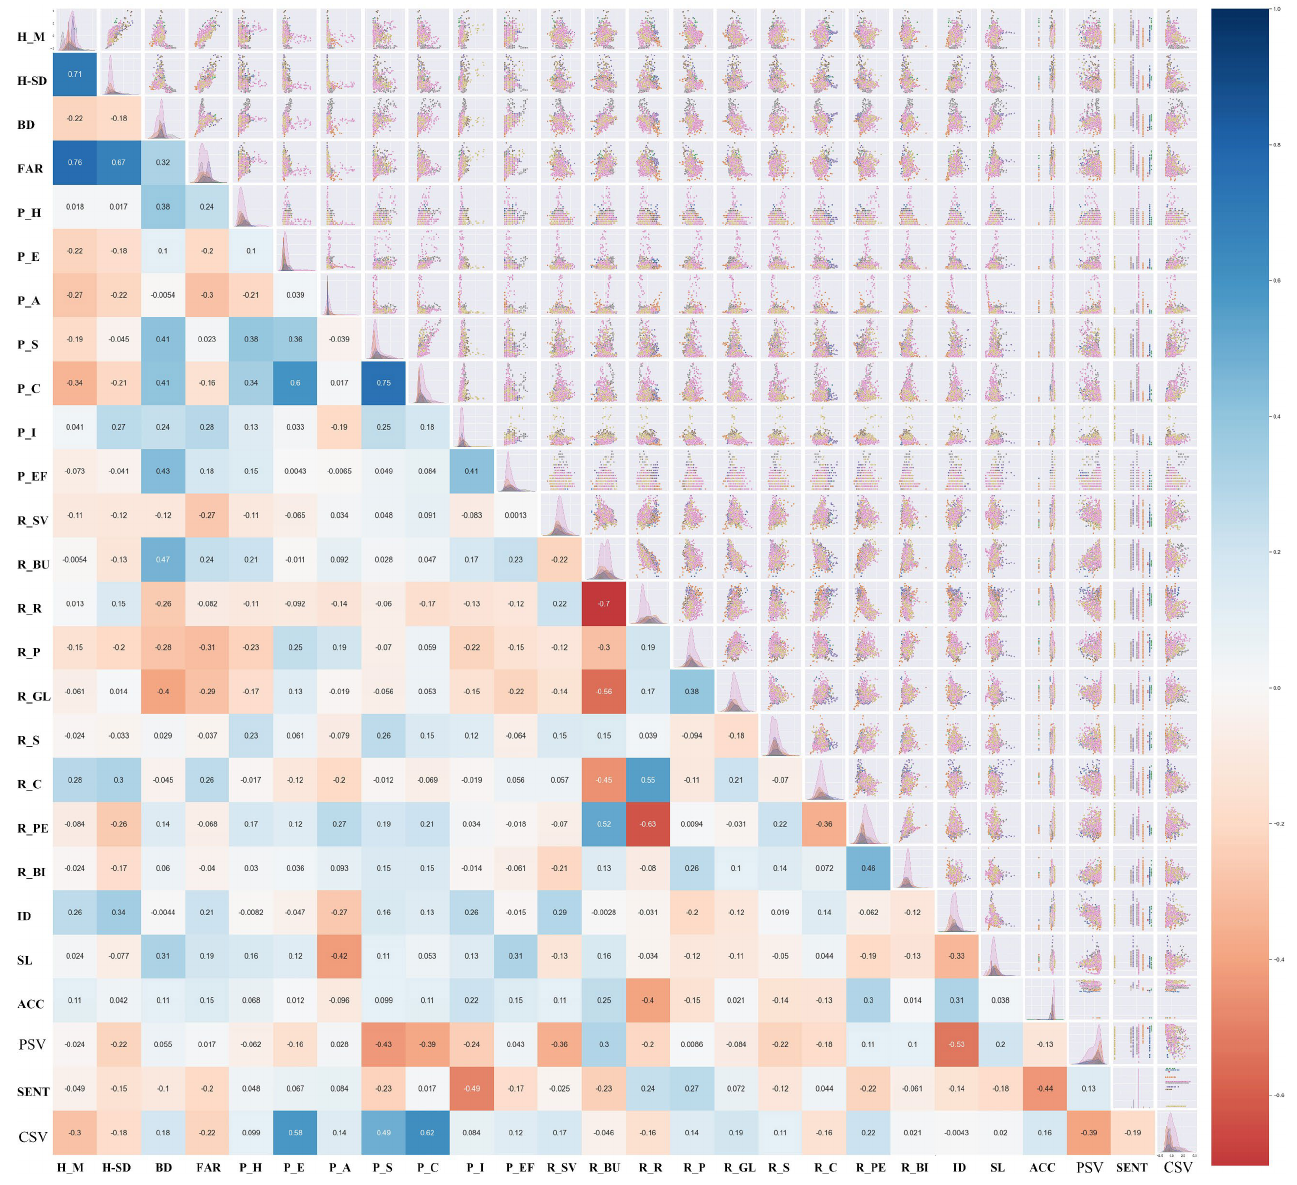
Figure 5. Pearson correlation coefficient matrix and the bivariate scatter matrix. Table 4. Performance of 3 models (test